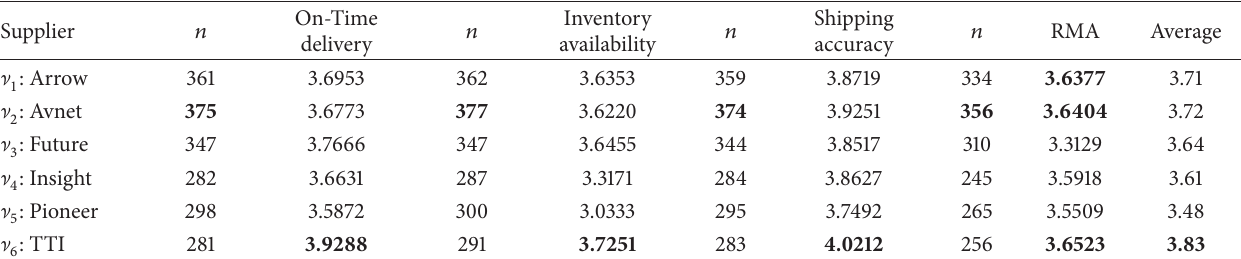
Table 7: Averaged operational parameter data for the six suppliers.